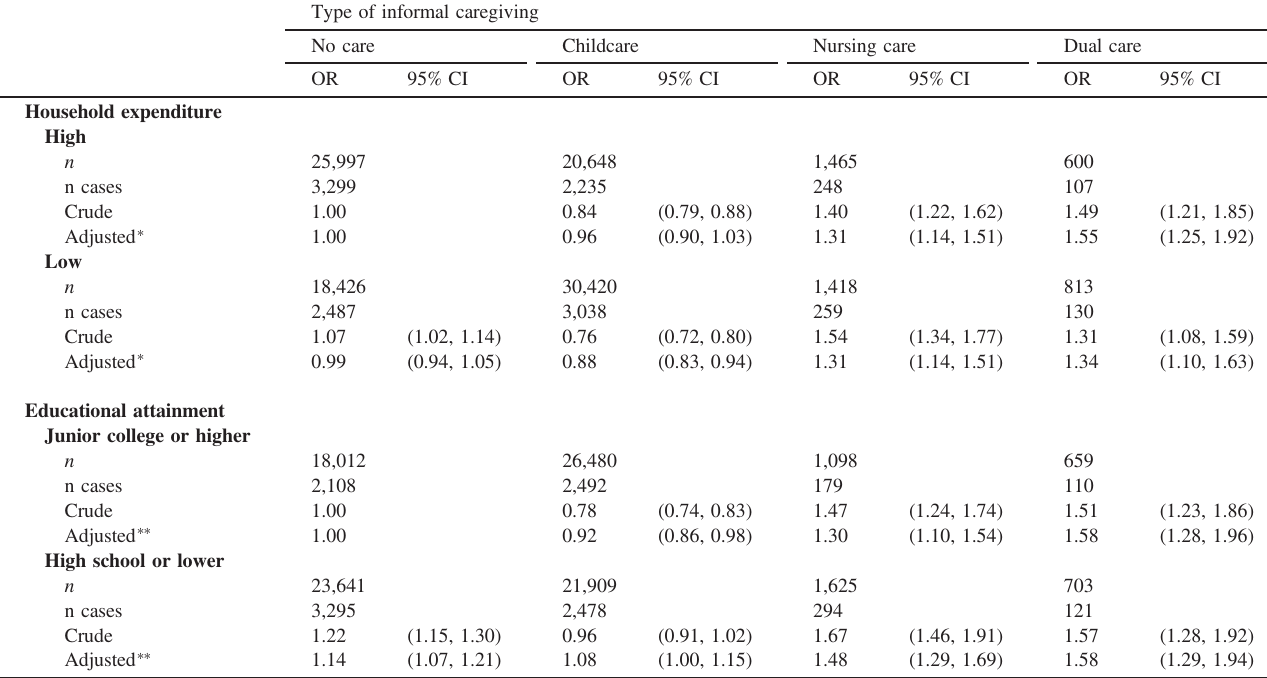
Table 3. Odds ratios for self-rated poor health associated with the types of informal caregiving by equivalent monthly household expenditure and educational